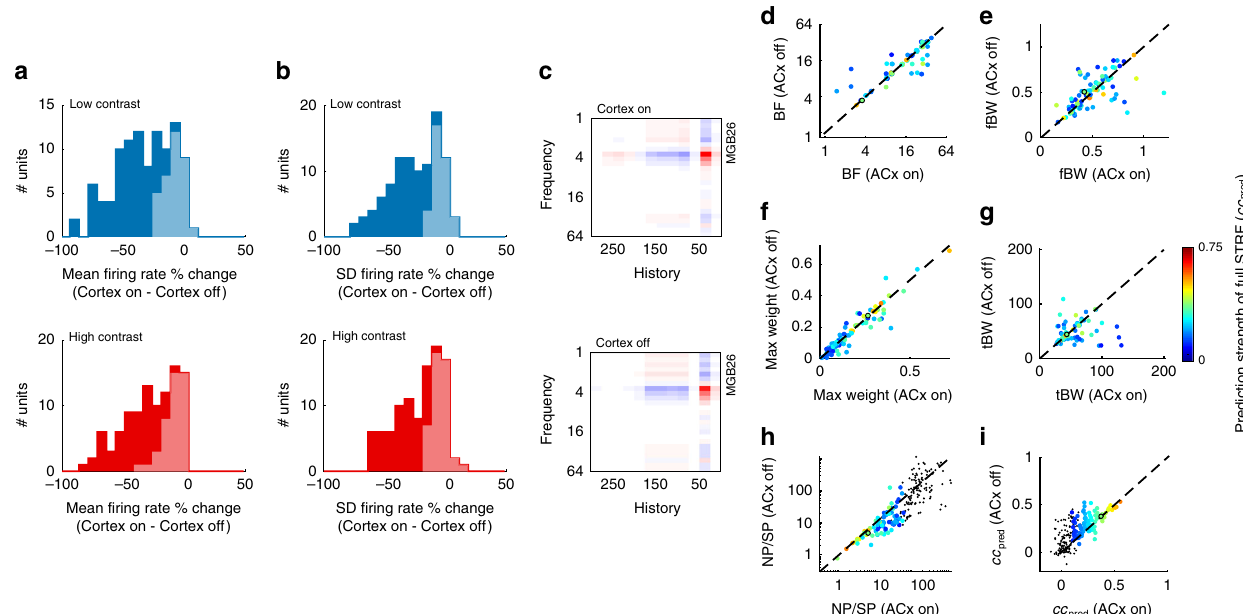
Fig. 4 Silencing auditory cortex decreases excitability in MGBv, increases reliability and linearity, but leaves STRF parameters unaffected. a Change in mean fi ring rate in MGBv during low-contrast (top, blue) and high-contrast (bottom, red) DRC stimulation following optogenetic cortical silencing. b Change in standard deviation (SD) of fi ring rate in MGBv during low-contrast (top) and high-contrast (bottom) DRC stimulation following optogenetic cortical silencing. Light shaded areas in a and b indicate units that were not signi fi cantly modulated by cortical silencing, while dark areas represent units that were affected by cortical silencing ( p < 0.05, t -test). c Example STRF (example is marked with black circle in panels d – i ) of an MGBv unit with auditory cortical activity intact (top), or auditory cortex optogenetically silenced (bottom) (red: positive, white: 0, blue: negative). d Comparison of the best frequency (BF), i.e., the largest value of the spectral kernel of the STRF, of MGBv units between recordings made with auditory cortical activity intact (ACx On) or optogenetically silenced (ACx Off). e Frequency bandwidth (fBW), i.e., the full-width half-maximum (in octaves) around the BF, of MGBv units with and without cortical silencing. f Value of the maximum weight of the STRF of MGBv units with and without cortical silencing. g Temporal bandwidth (tBW), h The ratio between noise and signal power (NP/SP) in the MGBv with and without cortical silencing. i Linear model prediction performance within contrast (cross-validated correlation between predicted and actual responses) in the MGBv with and without cortical silencing. Color of points in d – i denotes the prediction strength (correlation coef fi cient) of the model on a cross-validated dataset. Black dots are units excluded from analysis, according to exclusion criteria described in the Methods. Source data are provided as a Source Data fi